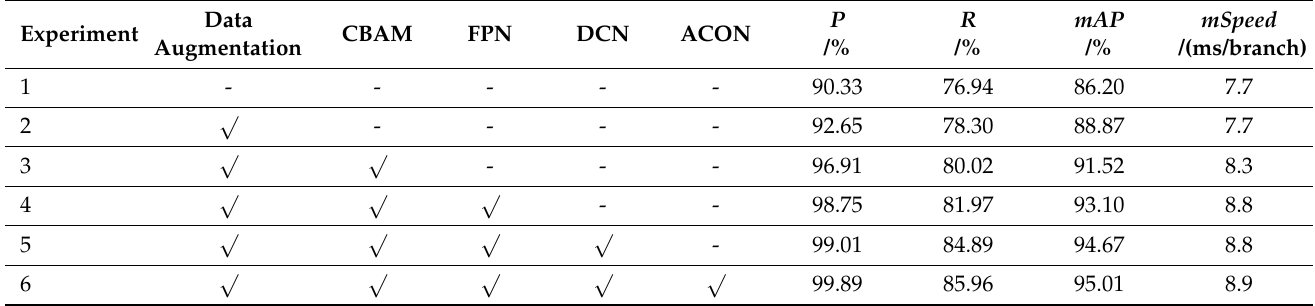
Table 4. Comparison of the results of adding different